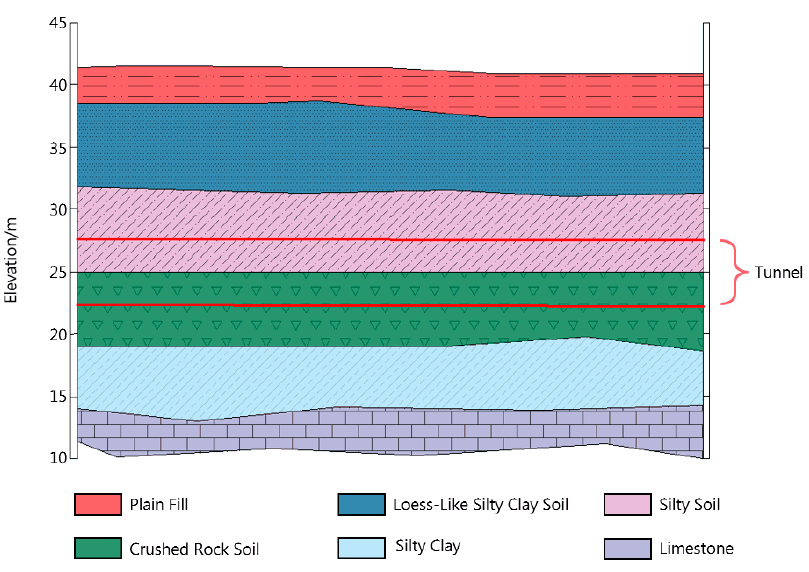
Figure 7. The suggested selection of buried depth of the underground structure in Jinan.